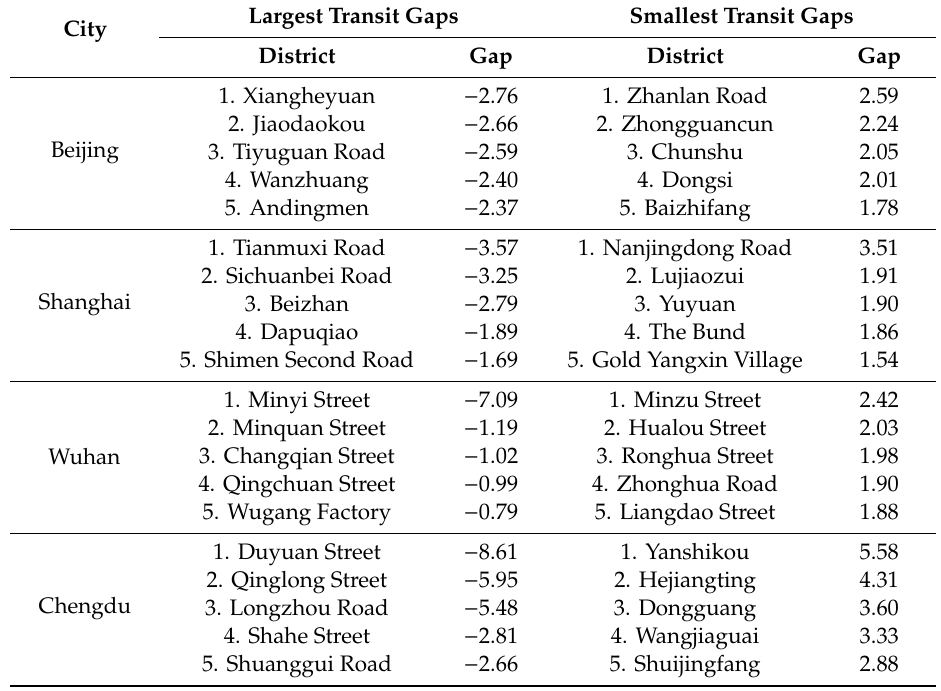
Table 2. Characteristics of transit gaps between supply and demand in Chinese metropolitan